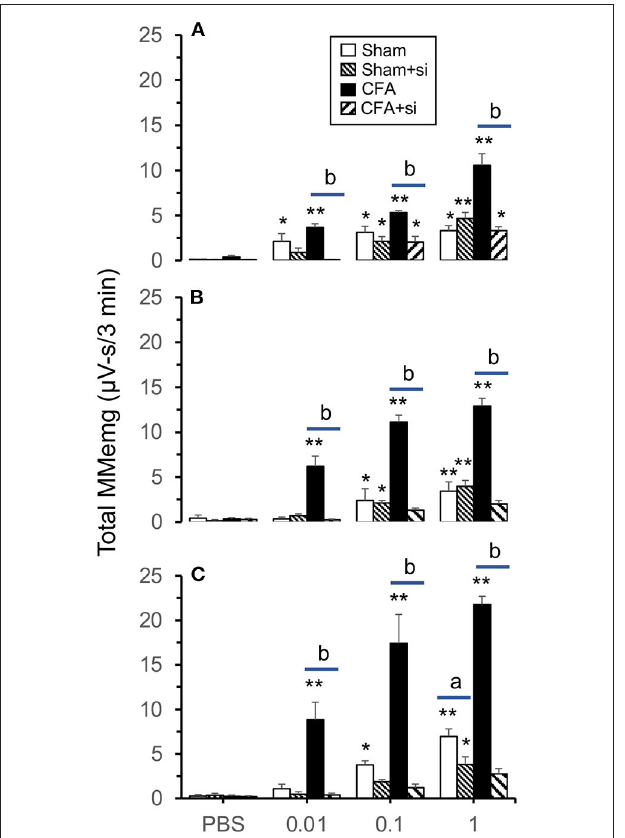
FIGURE 2 | siRNA for Cx43 inhibits intra-TMJ ATP-evoked MMemg activity in (A) male, (B) OvX and (C) OvXE females treated with CFA 10 days prior to